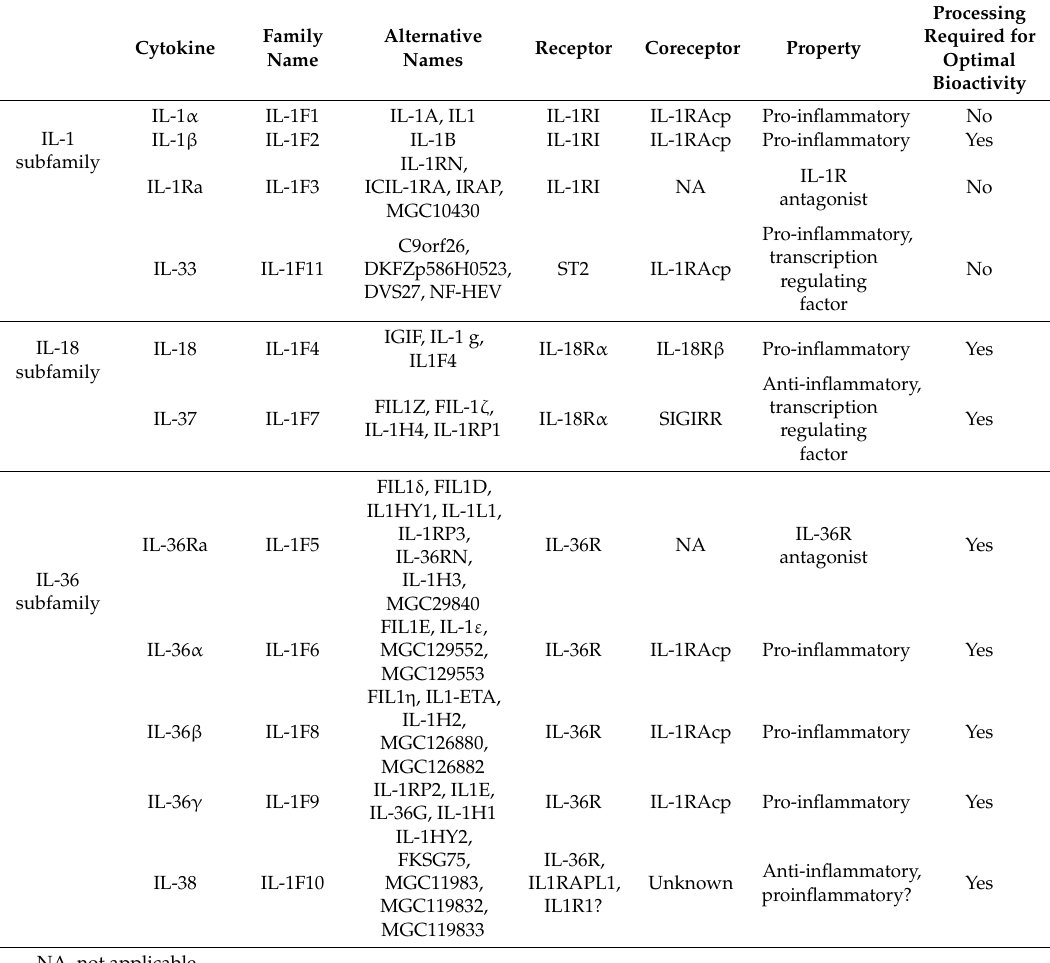
Table 1. The subfamily of IL-1